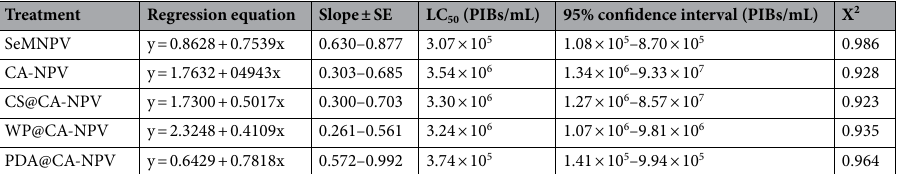
Table 1. Regression equation, correlation coefficients, and LC 50 between the SeMNPV and microcapsule formulations and the mortality of 3 rd instar larvae.